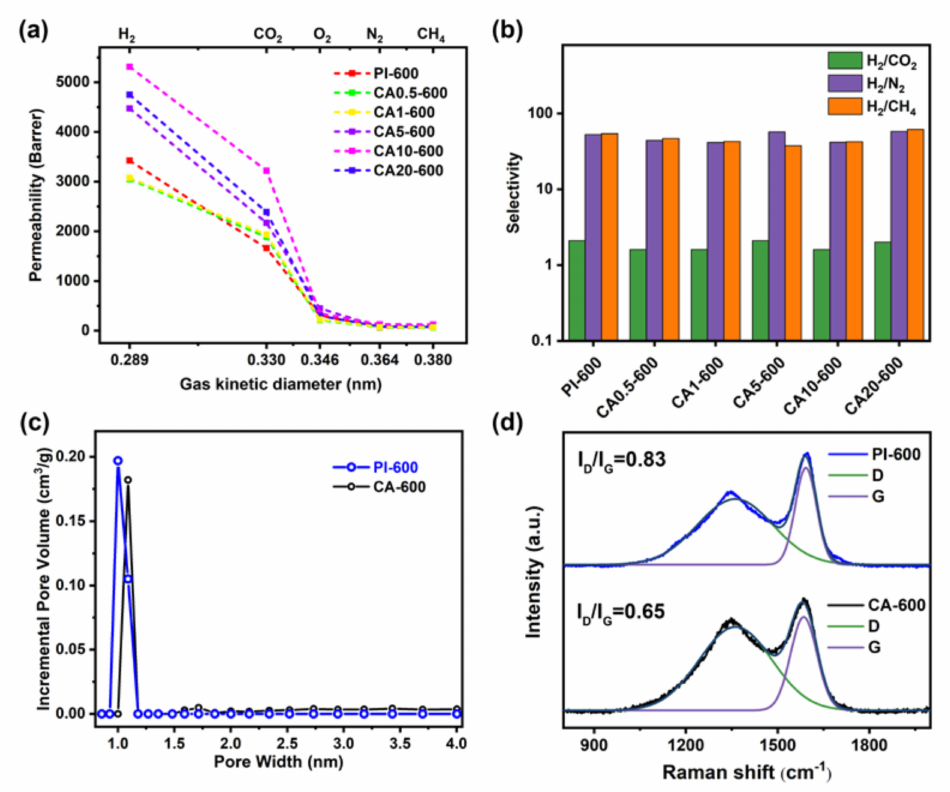
Figure 12. Gas permeability ( a ) and selectivity ( b ) of CMSMs; ( c ) pore size distribution curves based on N 2 sorption and ( d ) Raman